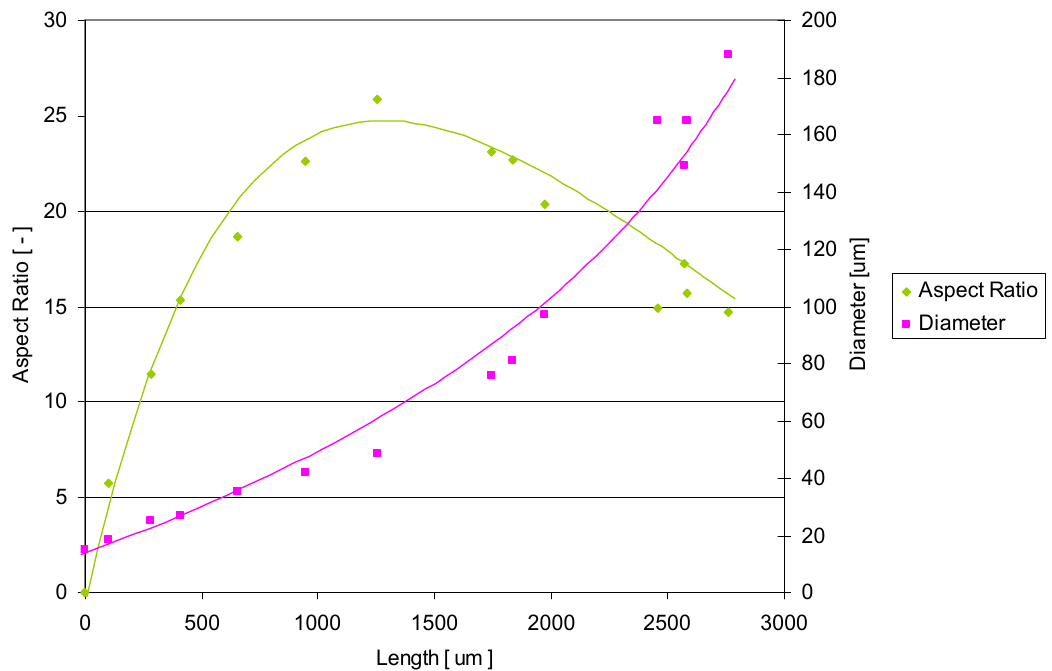
Figure 3 . Diameter (Red) and Aspect Ratio (Green) of the sample that undergone the 2 min etching time in Section 2.2.